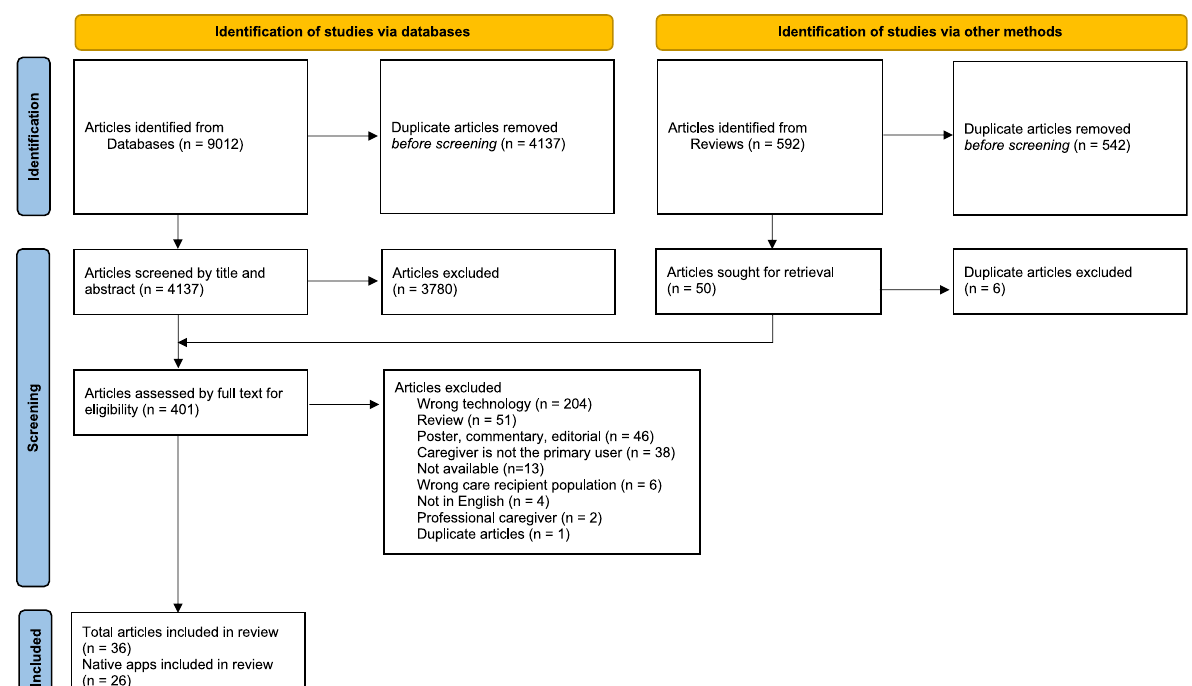
Fig. 1 Flow diagram. Preferred reporting items for systematic review and meta-analysis (PRISMA) fl ow diagram of the literature search 19